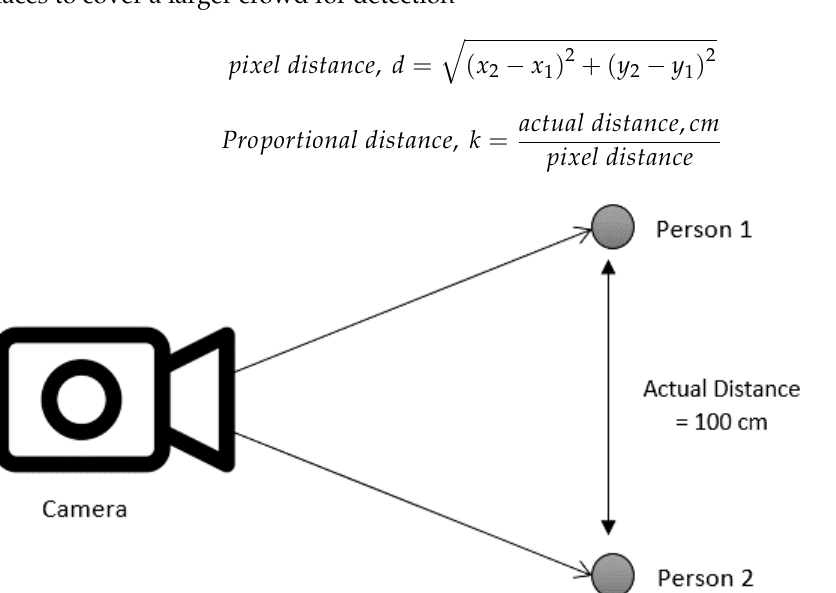
Figure 5. Determination of actual distance from the pixel distance at a fixed camera distance.